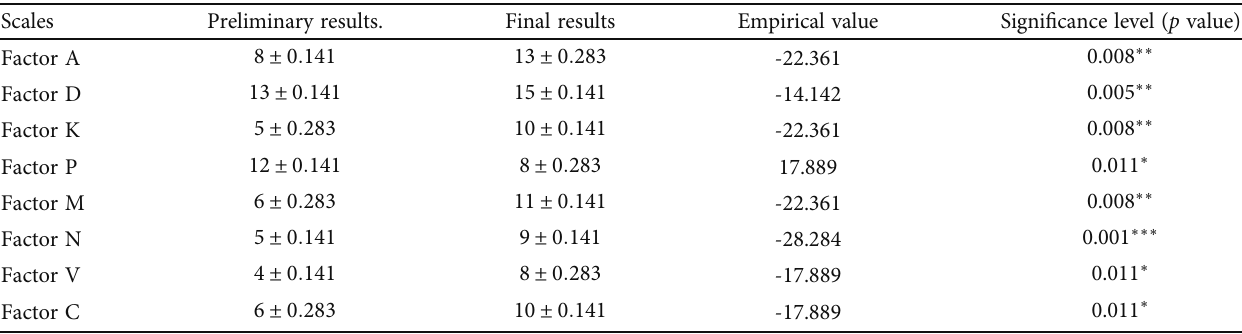
Table 4: Comparison of the